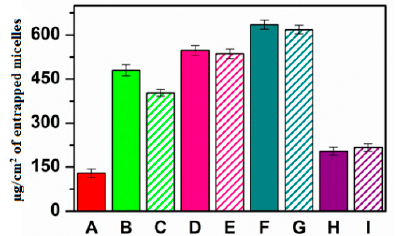
Figure 5. Ex vivo penetration studies: μ g/cm 2 of fluorescent-labeled micelles accumulated in the corneal tissue at the end of each experiment after administration of (A) INU-EDA-RA (red), (B) INU-EDA-RA-PEG (green), (C) INU-EDA-RA + PEG solution (green lines), (D) INU-EDA-TAU-RA (pink), (E) INU-EDA-RA + TAU solution (pink lines), (F) INU-EDA-RA-CAR (petrol green), (G) INU-EDA-RA + CAR solution (petrol green lines), (H) INU-EDA-RA-CRE (violet), (I) INU-EDA-RA + CRE solution (violet lines). Significance: p < 0.05.